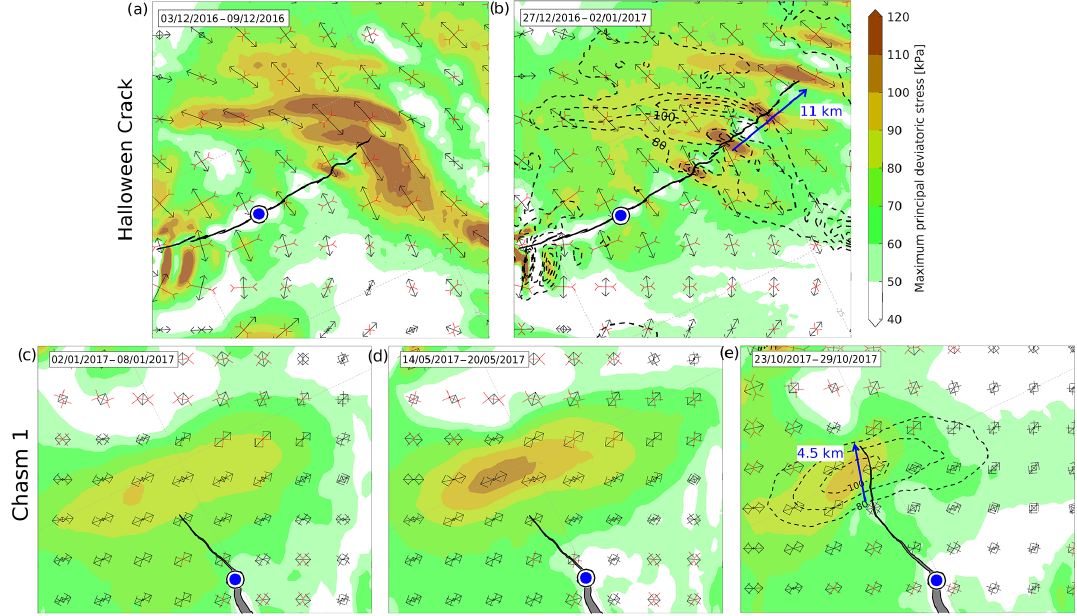
Figure 3. Build-up and subsequent reduction in tensile stress during discontinuous rift propagation. (a, b) Halloween Crack remained stagnant for most of November 2016 resulting in the localized accumulation of stress, before propagating 11km in December 2016 and causing a significant release of stress. (c–e) Chasm 1 lengthened by only 500m in 2016 compared to 1.5kmyr − 1 in preceding years, and by January 2017, a zone of high tensile stress developed ahead of the rift tip (panel c ). This zone intensified by May 2017 (panel d ) and tension dissipated by October 2017 (panel e ), following a rapid progression by 4.5km. For reference, the blue markers indicate the location of rift initiation as in Fig. 2, and the dashed contours panels (b) and (e) correspond to the stresses before